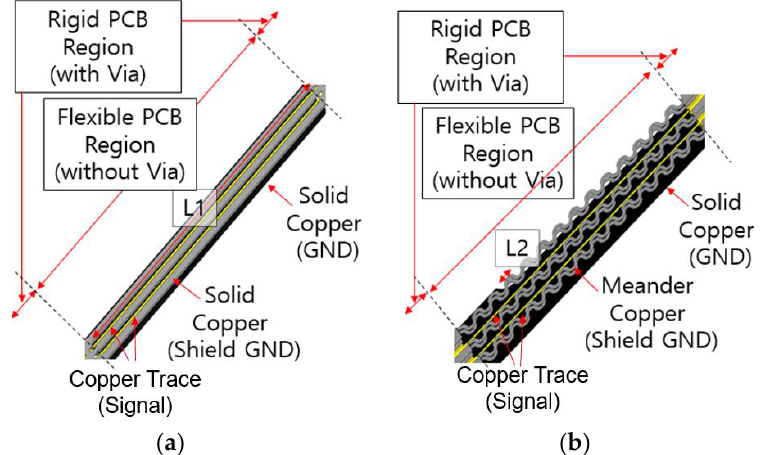
Figure 6. Conceptual diagram of a structure using two ground layers.